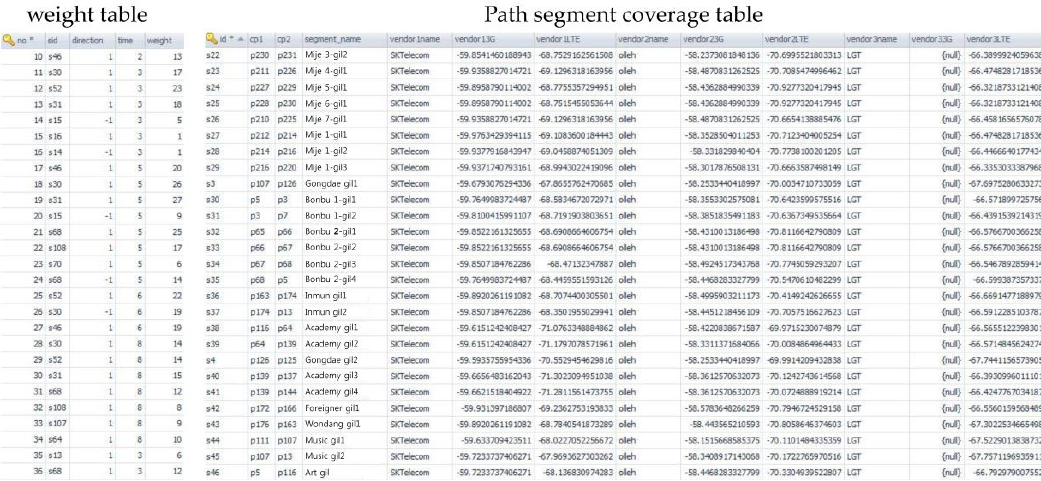
Figure 9. Snapshot of implementation using network coverage information.